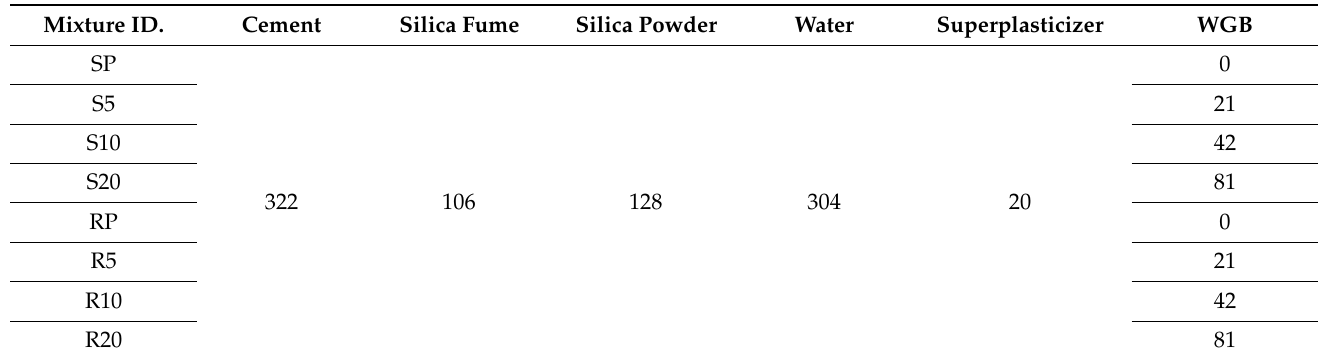
Table 3. Mix proportions of specimens (per cubic meter of specimens, kg/m 3